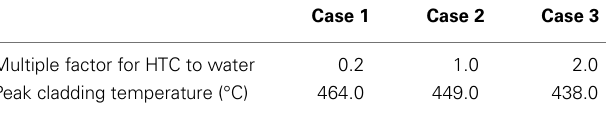
Table 6 | Sensitivity analysis on HTC to water .